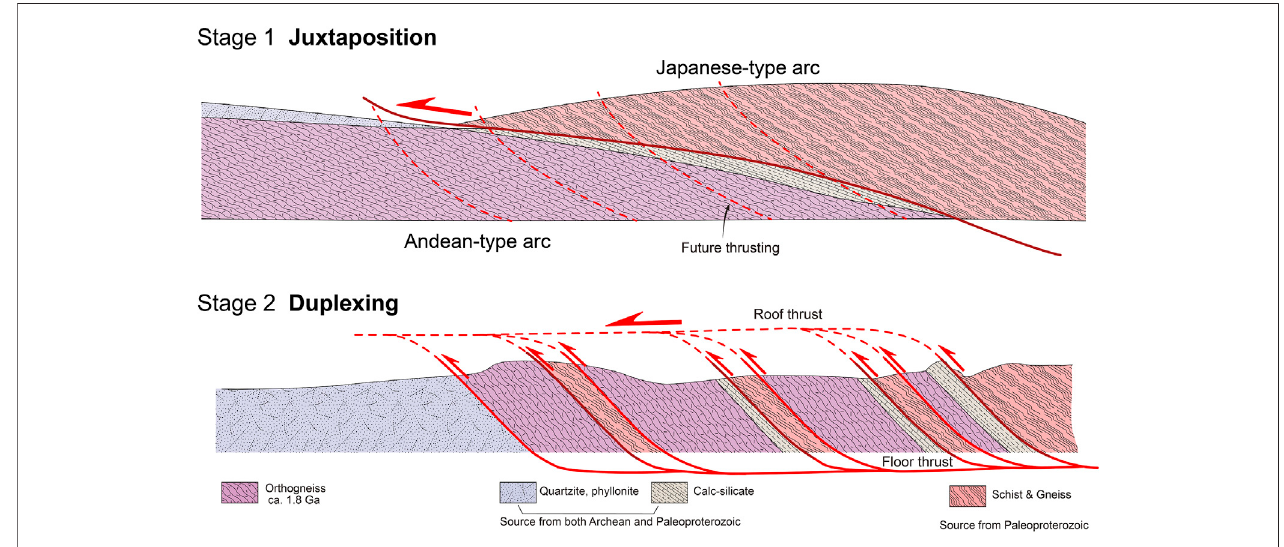
FIGURE 14 | Schematic diagrams of the structural and tectonic evolution of the two-arc system along the northern Indian Craton. At stage 1 of juxtaposition, the margin of the Japanese-type arc with unimodal source thrusted over the margin of the Andean-type arc with bimodal source. At stage 2 of duplexing, the out-of- sequence thrust system formed the modern structure of the Arun